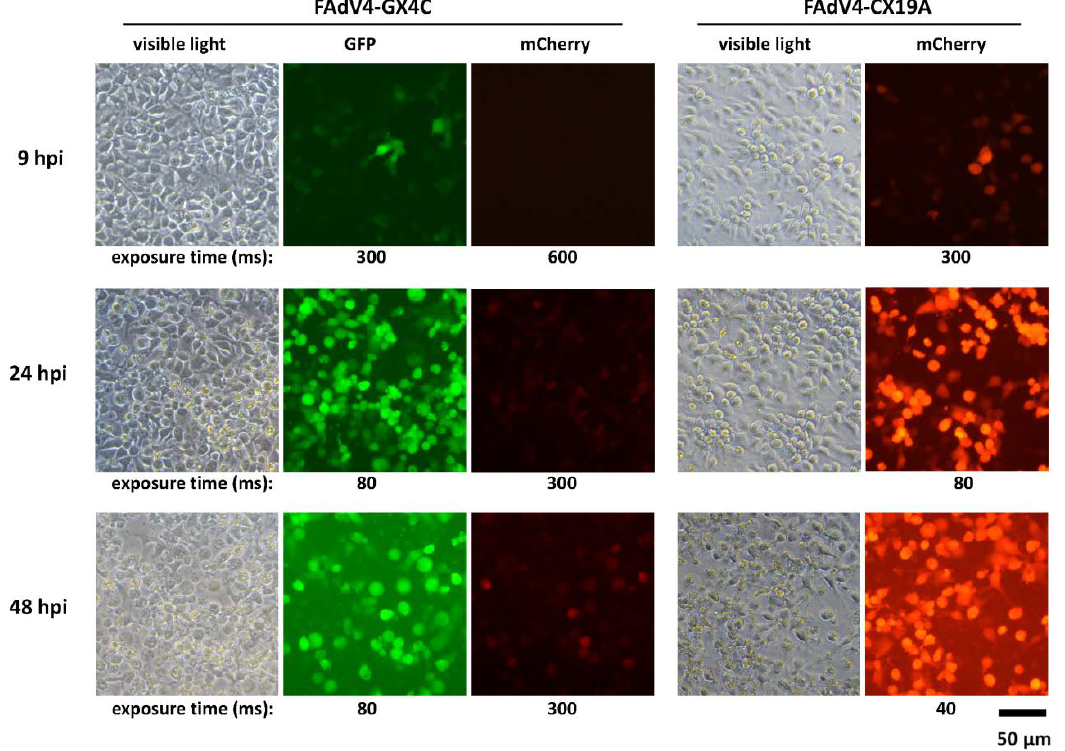
Figure 7. Expression of mCherry under the ORF4 promoter of FAdV-4. LMH cells were infected with FAdV4-GX4C and FAdV-CX19A. The expression of GFP and mCherry was observed